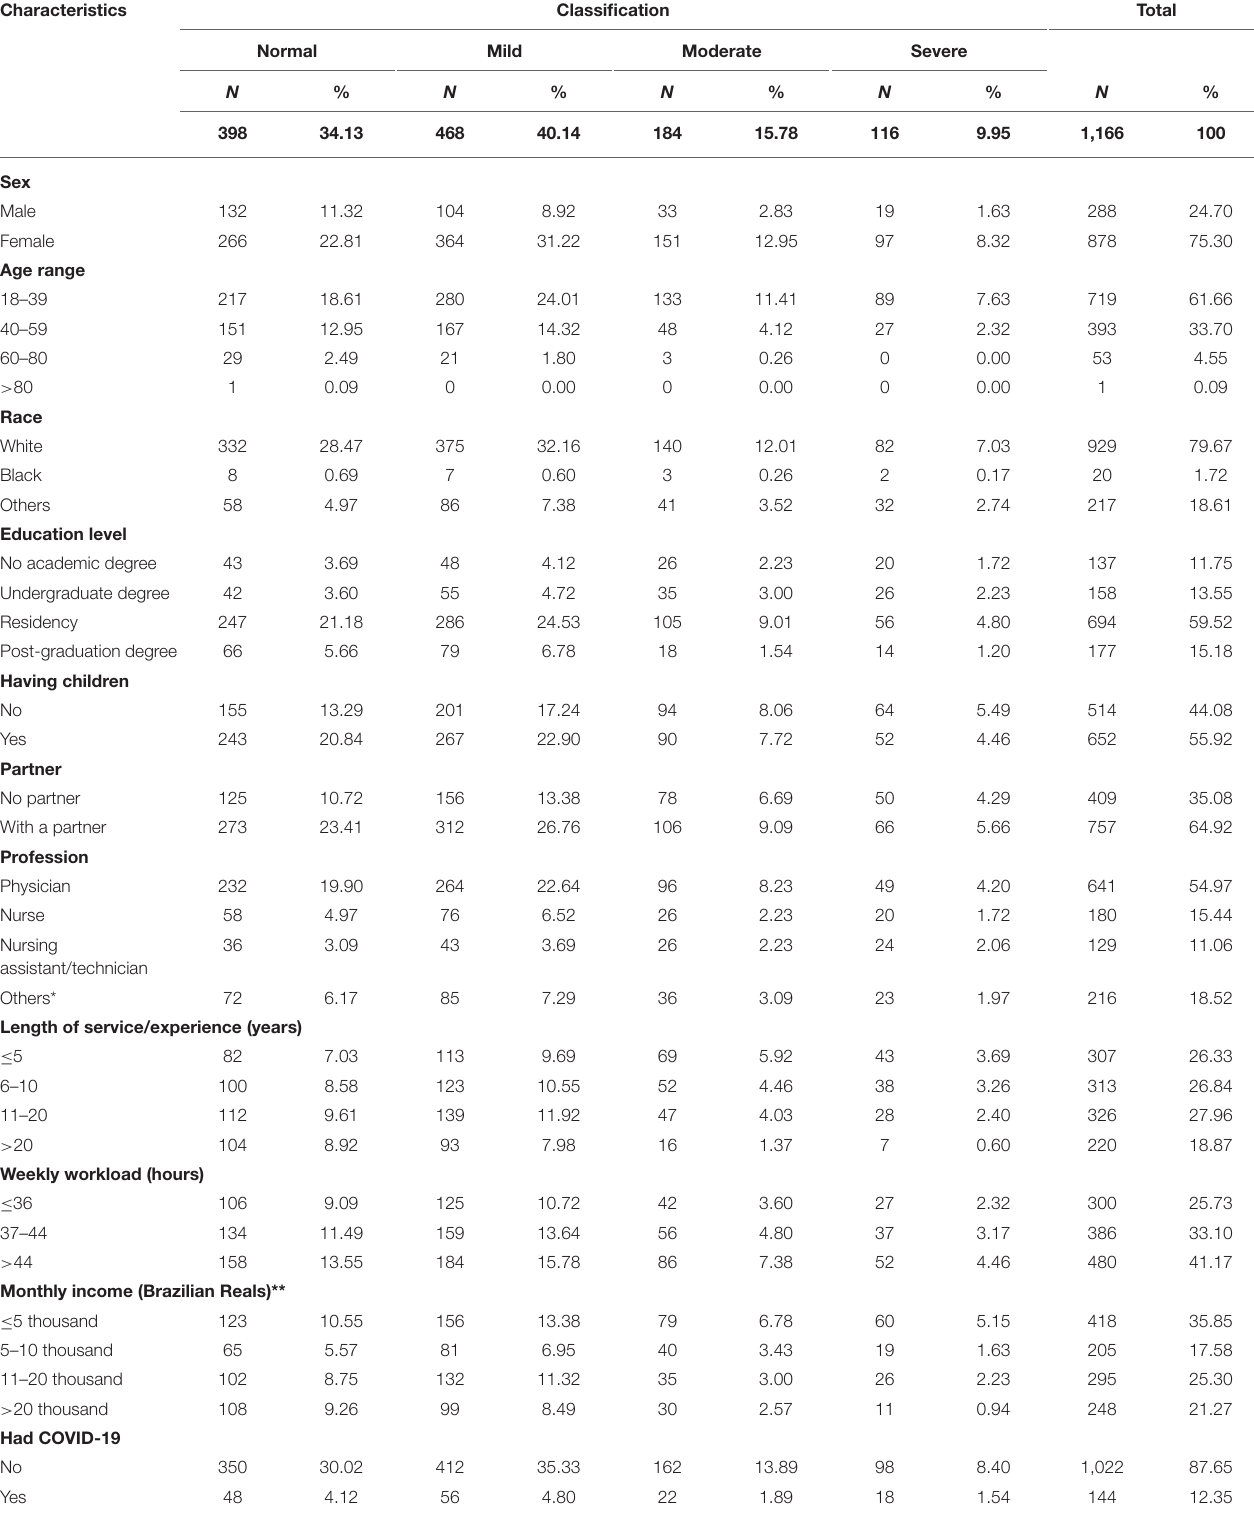
TABLE 1 | Sociodemographic and professional characteristics of the participants according to their anxiety level. Characteristics